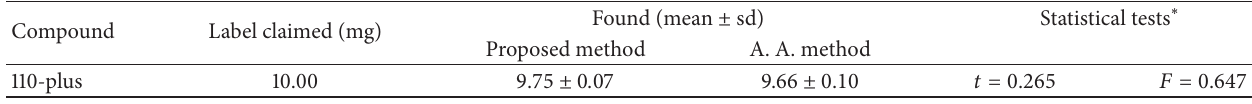
Table 4: Application of the proposed method to the determination of Cu(II) in amalgam ( 𝑛 = 3 ).